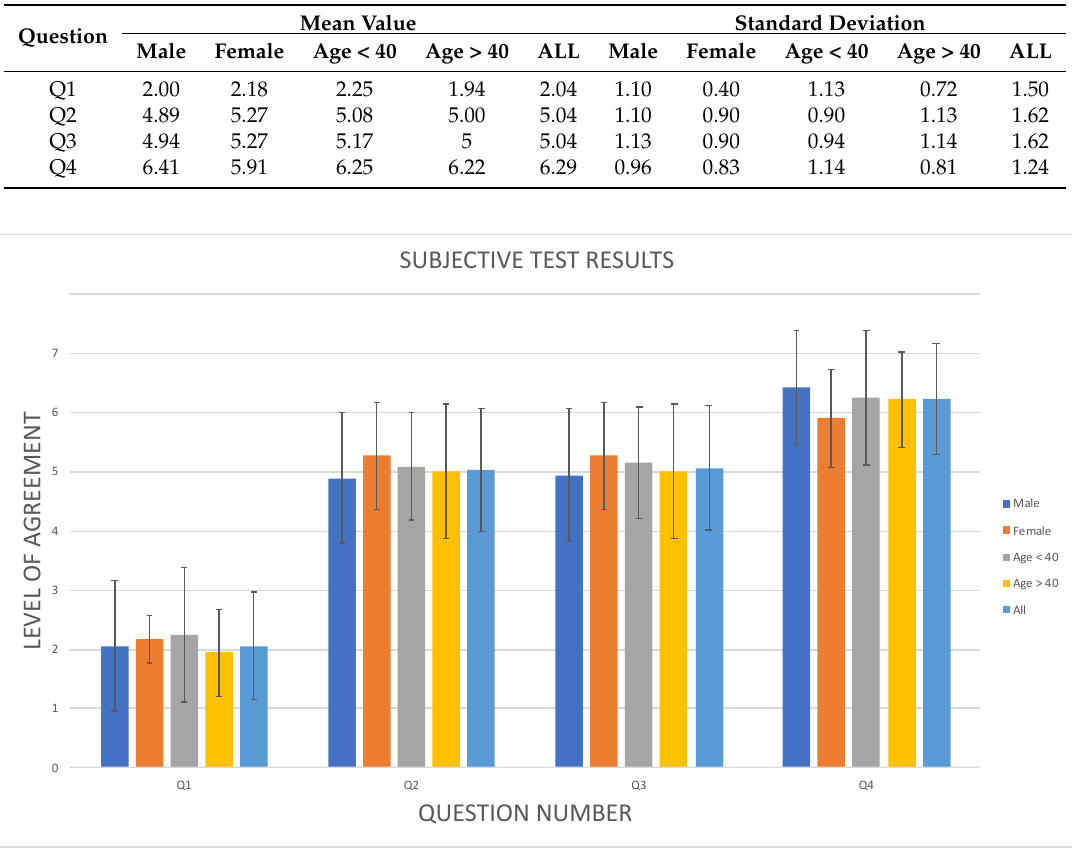
Figure 14. Subjective test results. The values reported in Table 3 are depicted in graphical format. The solid bars represent the mean value and the lines the standard deviation of the level of agreement (from 1 to 7) for the reply of the following five categories: male, female, age below 40, age above 40, all the persons in the